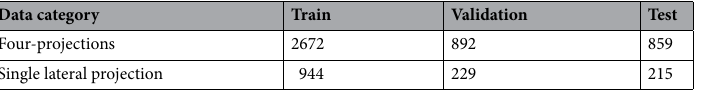
Table 3. The number of images in train, validation and test set in 4-projection and lateral dataset.